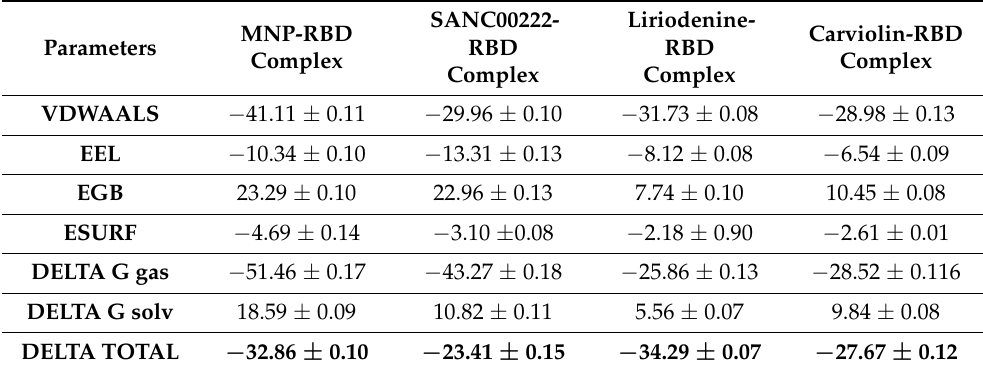
Table 2. Binding free energy calculations using MM/GBSA